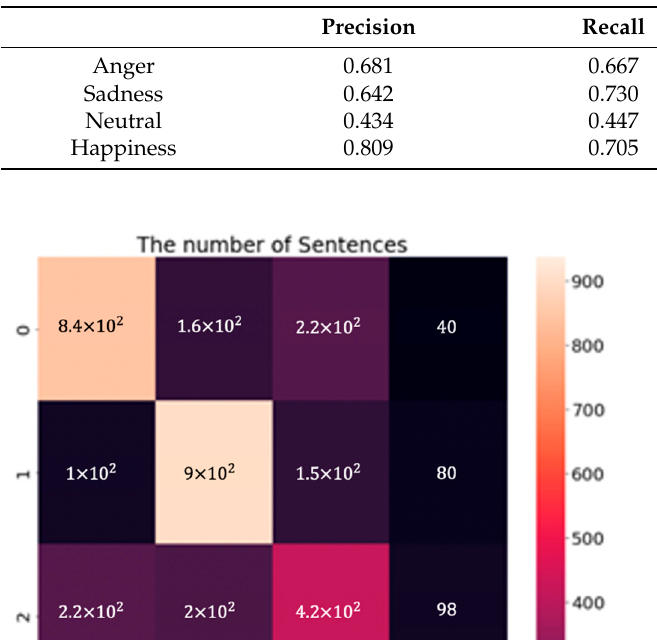
Table 4. Precision, Recall, and F1-score of GRU model trained by the combined dataset.